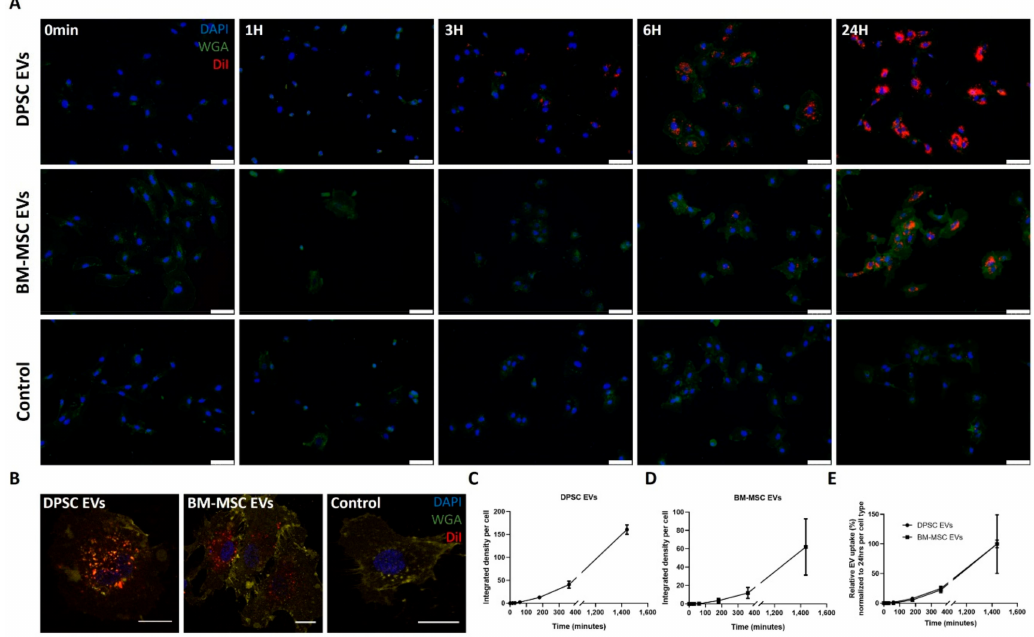
Figure 4. Time-dependent uptake of DPSC- and BM-MSC-derived EVs by endothelial cells. DiI-labelled EVs of DPSCs or BM-MSCs were co-cultured with HUVECs and their uptake was visualized by fluorescence microscopy at di ff erent time points ( n = 3, 3 di ff erent donors). EV-free medium